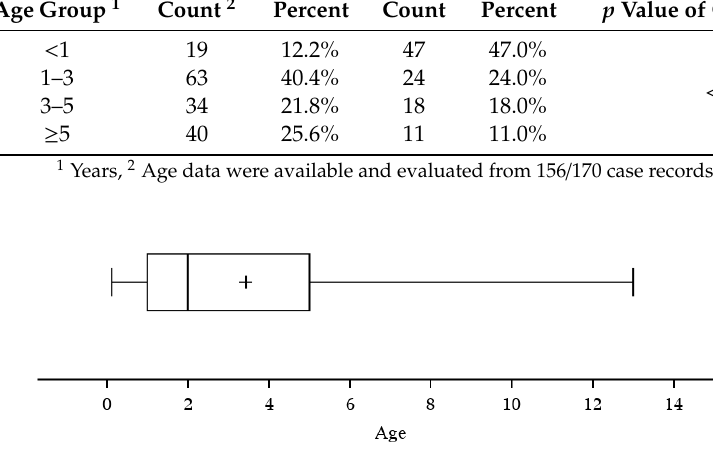
Figure 5. Acute cytauxzoonosis cases by age (years).